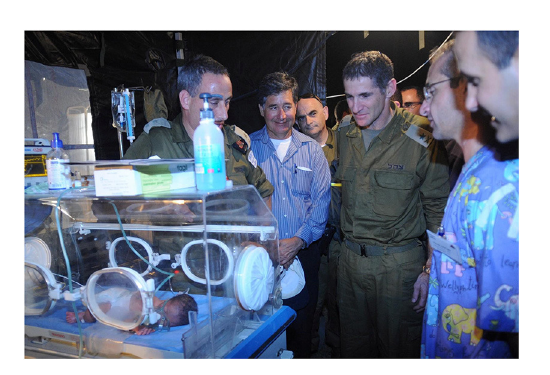
FIGURE6 OC Home Front Command, Maj. Gen. Yair Golan, pictured here on a visit to the IDF Field Hospital in the premature baby maternity ward. After the devastating earthquake which struck Haiti in January 2010, Israel sent an aid delegation of over 250 personnel to help with search and rescue efforts and establish a field hospital in Port-au-Prince. Source: Public domain image, not in copyright. Available at: https://commons.wikimedia.org/ wiki/File:Flickr_-_Israel_Defense_Forces_-_Head_of_Home_ Front_Command_Visits_Aid_Delegation.jpg